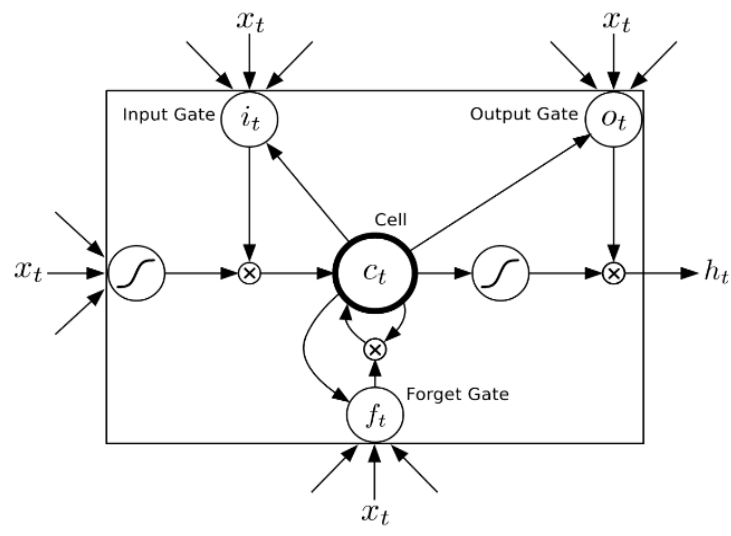
Figure 2. Flowchart of the basic LSTM network.